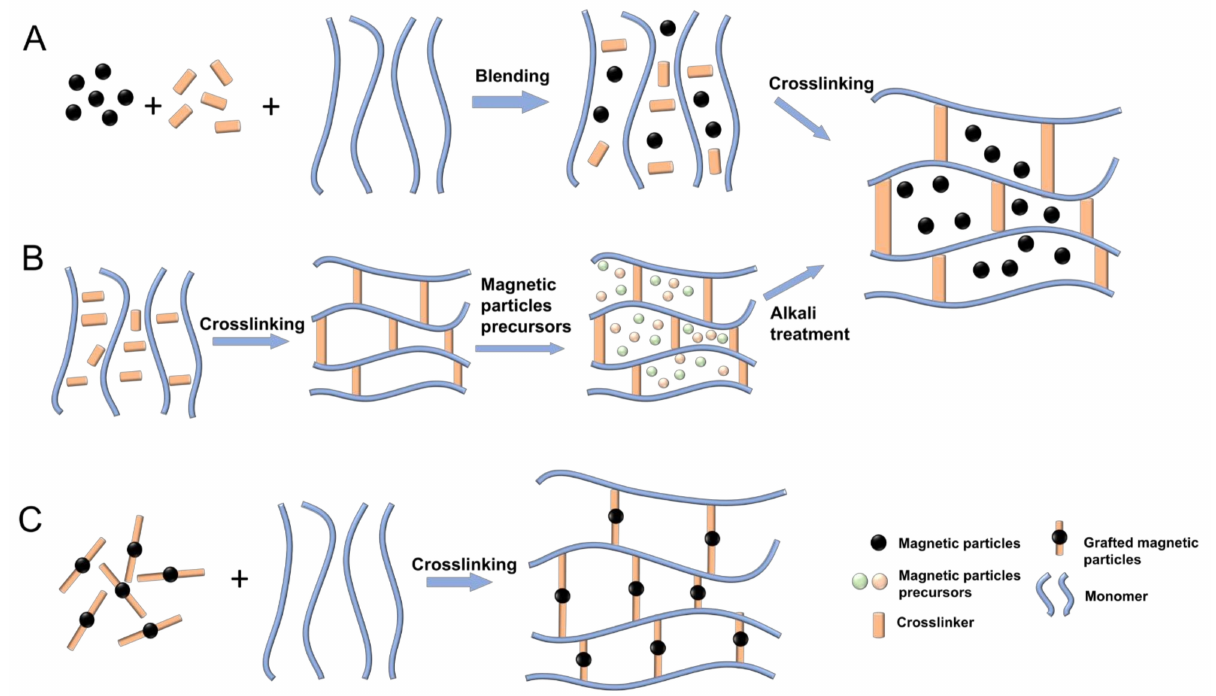
Figure 2. Scheme of different manufacturing techniques for magneto-active hydrogels or ferrogels: ( A ) blending method; ( B ) in situ precipitation method; ( C ) grafting-onto